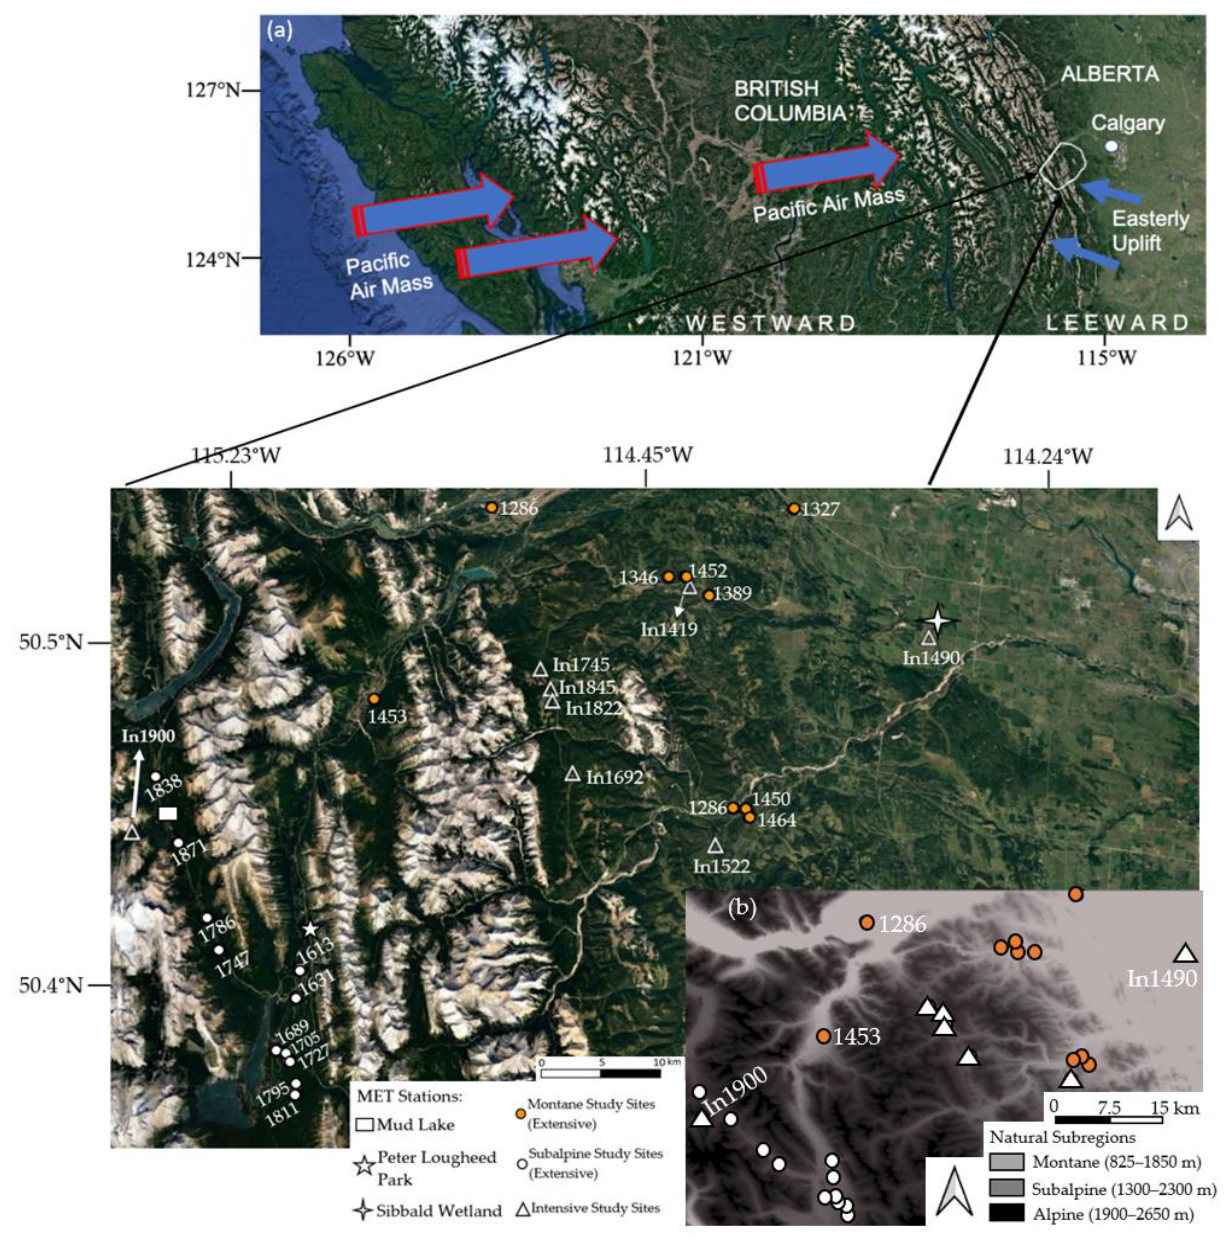
Figure 1. Site map illustrating isotope sampling and MET station locations. Extensive sites in the Montane Natural Subregion are shown in orange circles ( n = 9) and sites in the Subalpine Natural Subregion are shown by white circles ( n = 11) with black outline. Intensive sites are depicted by white triangles ( n = 8). The white arrows point to site label. The surrounding area from Calgary (East) to the Pacific Ocean including influential air masses from the Pacific Ocean and Easterlies from the Gulf of Mexico is shown in ( a ). Study site is shown by the white outline. Classic orographic effects occur on the westward side resulting in rain out of heavier isotopes at low elevations (shown). Mixing of pacific air mass and easterlies occur on the leeward side. Digital Elevation Map of the study site using geospatial data from Government of Canada shown in ( b ). Natural Subre- gions of Interest are depicted by color.